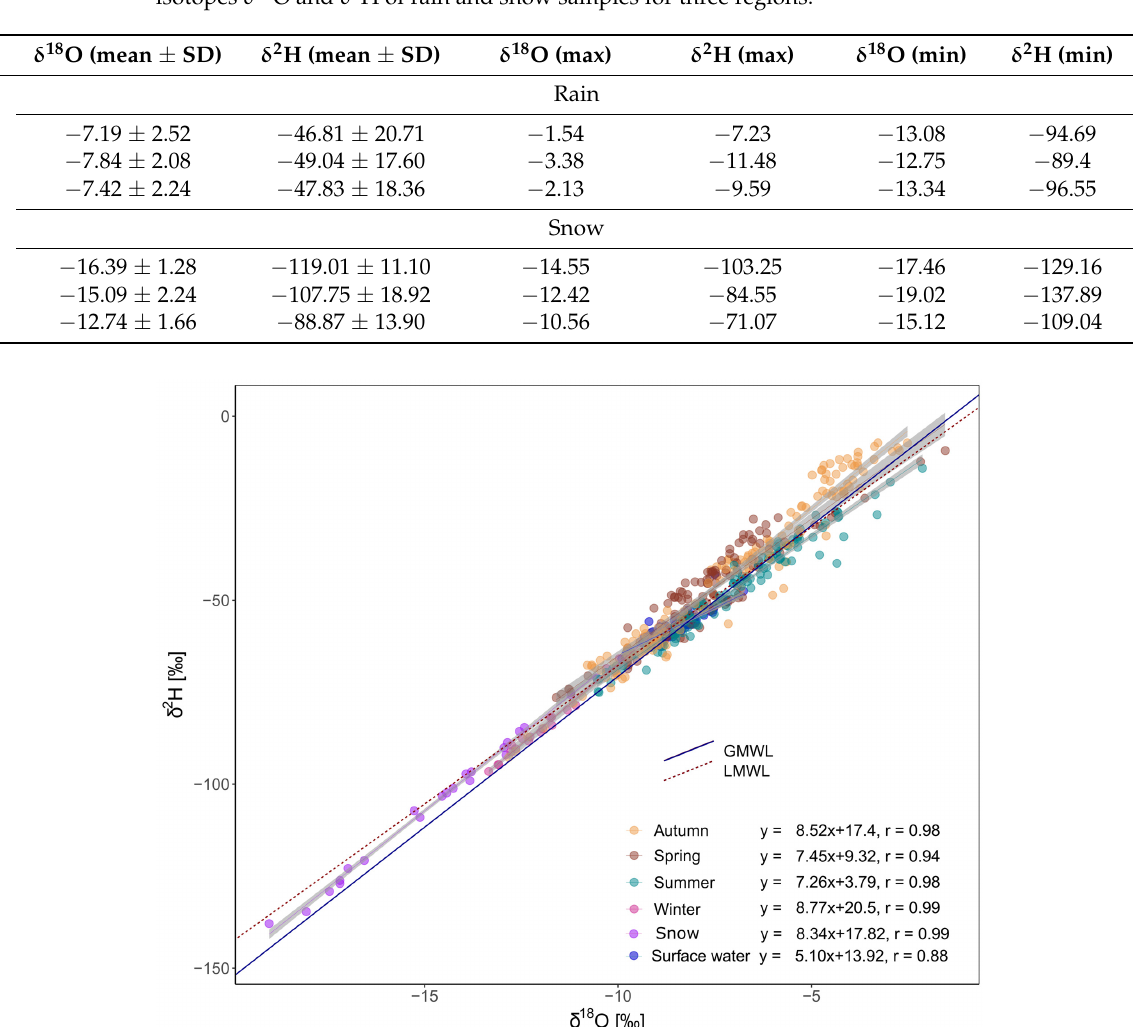
Table 2. Mean ± standard deviation (SD), maximum (max), and minimum (min) values for stable isotopes δ 18 O and δ 2 H of rain and snow samples for three regions.